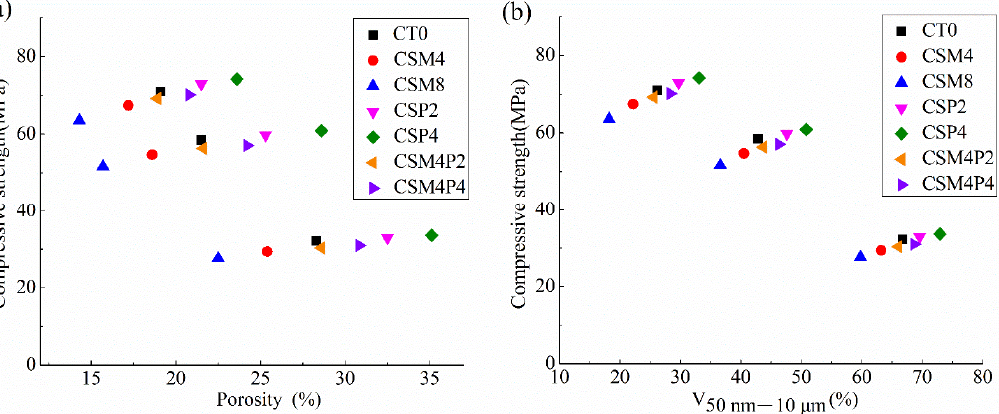
Figure 9. The relationship between the compressive strength and ( a ) porosity and ( b ) V 50 nm–10 μ m of hydraulic concretes containing MgO and/or PVA fiber.